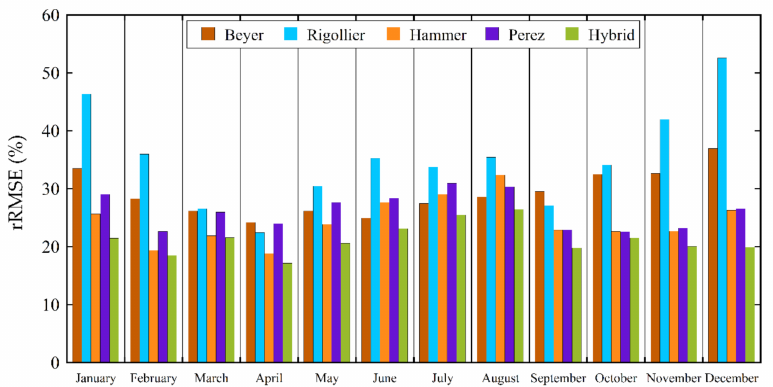
Figure 9. Comparison of monthly accuracy based on rMBE